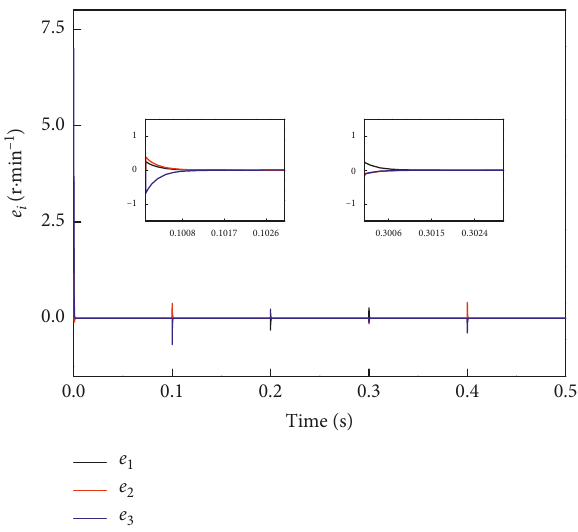
Figure 17: The system error curves under multiple